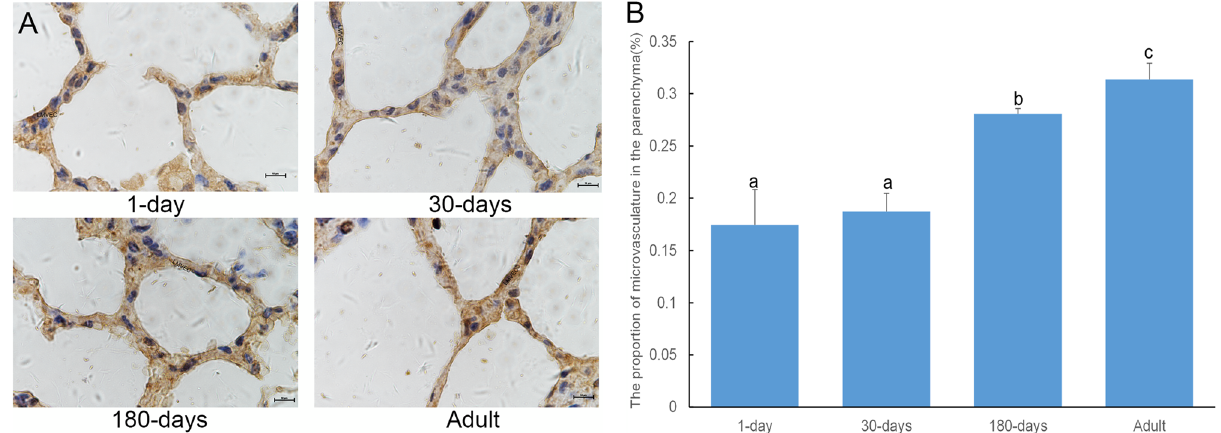
Figure 2. Immunohistochemical staining of yak pulmonary microvascular sections with CD34 at different developmental stages. ( A ) Representative sections from 1-day old animals through to adults (scale bar represents 10 µm, 1000×). Cells stained brown represent positive protein expression results. CD34 was mainly distributed in vascular endothelial cells, showing a high level of expression. ( B ) The graph represents a densitometric analysis of immunohistochemical staining. CD34 content was quantified using Image-Pro Plus software. Values represent the mean ± SD (n = 3). Significant differences are indicated by letters (a, b, c, and d), P < 0.05. LMVEC, the lung microvessel endothelial